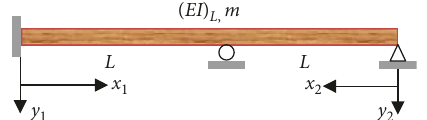
Figure 2: A two equal span continuous timber floor beam with left end fixed and right end simply